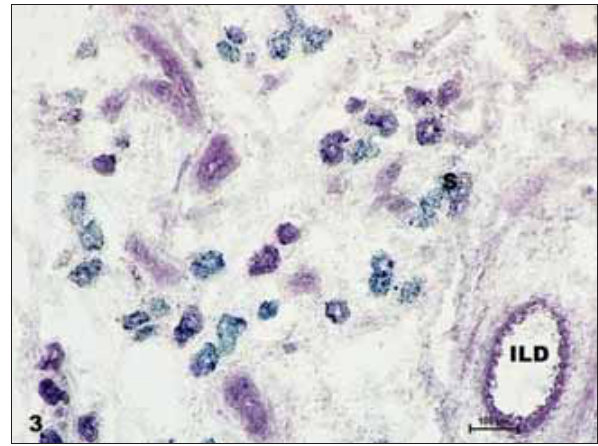
Figure-1: Photomicrograph showing weak to moderate glutamic dehydrogenase activity in serous acinar cells (S) and duct (D) of submandibular salivary gland of buffalo fetus at 28 cm curved crown-rump length (136 days) (Nitro BT method × 100).